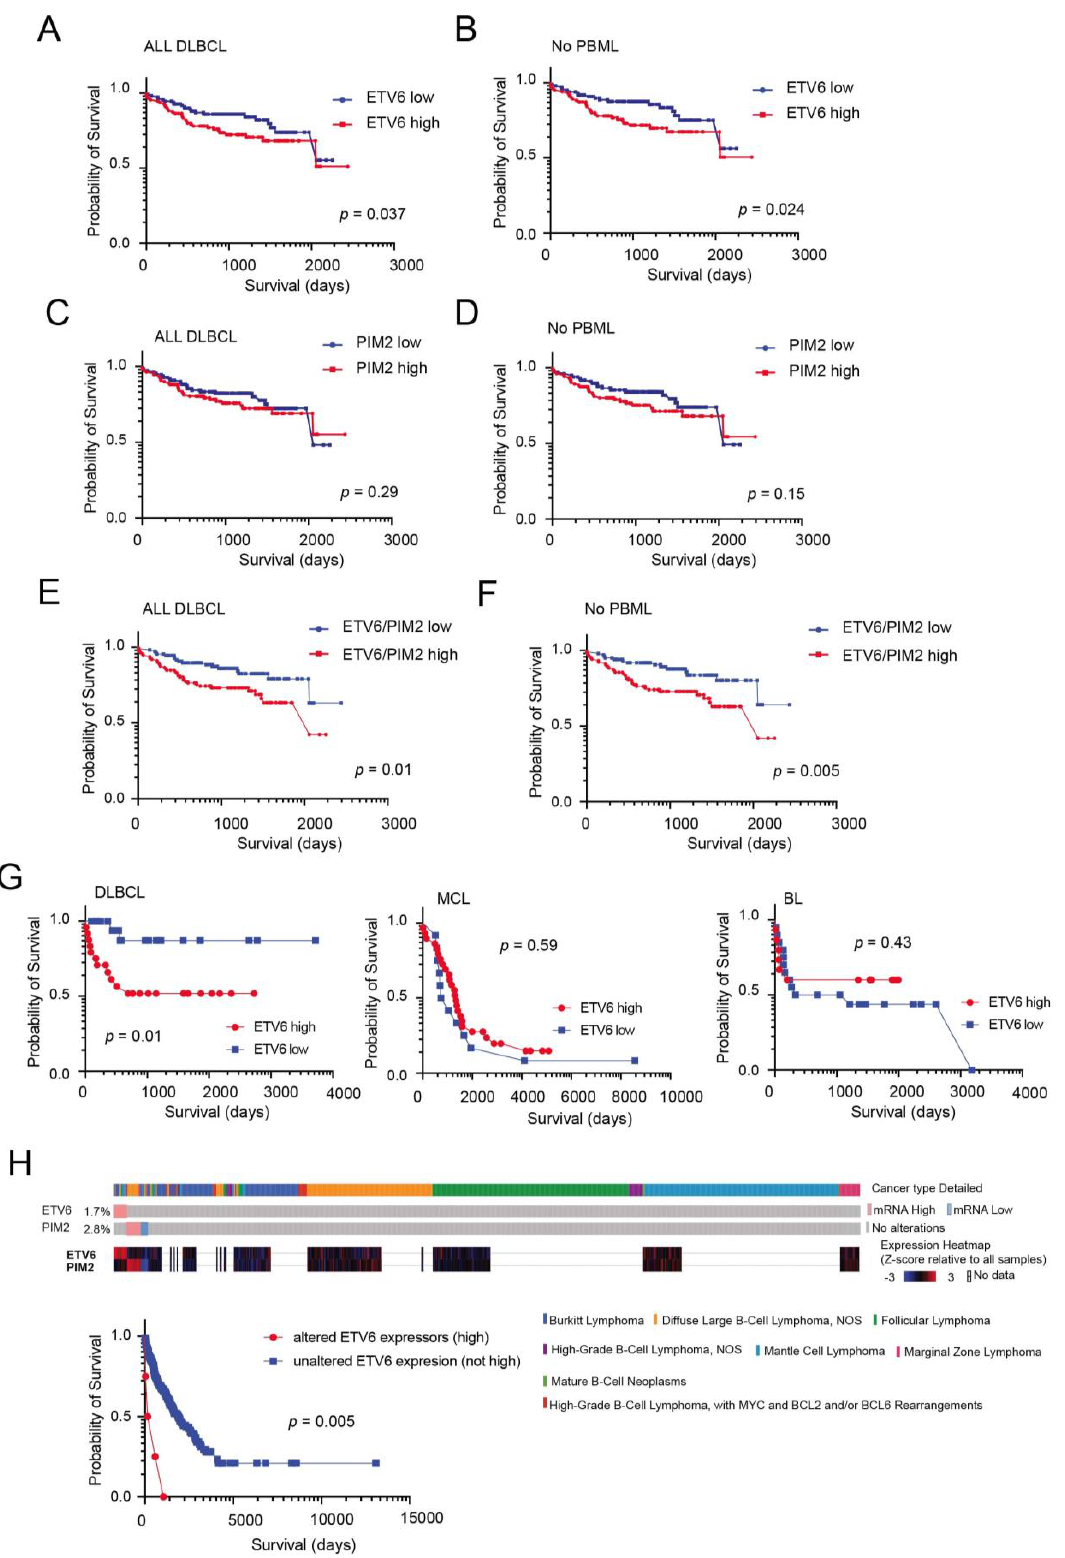
Figure 4. High ETV6 or ETV6/PIM2 levels predict poor survival in B-cell lymphomas. Kaplan–Meier survival curves of the entire series of 223 DLBCL patients [25], analysed as a group ( A ) or excluding PBML cases ( B ). ETV6 (probe 235056_at) high cases (>median expression) or ETV6 low cases (<median expression). Kaplan–Meier survival curves of the entire series of 223 DLBCL patients [25],